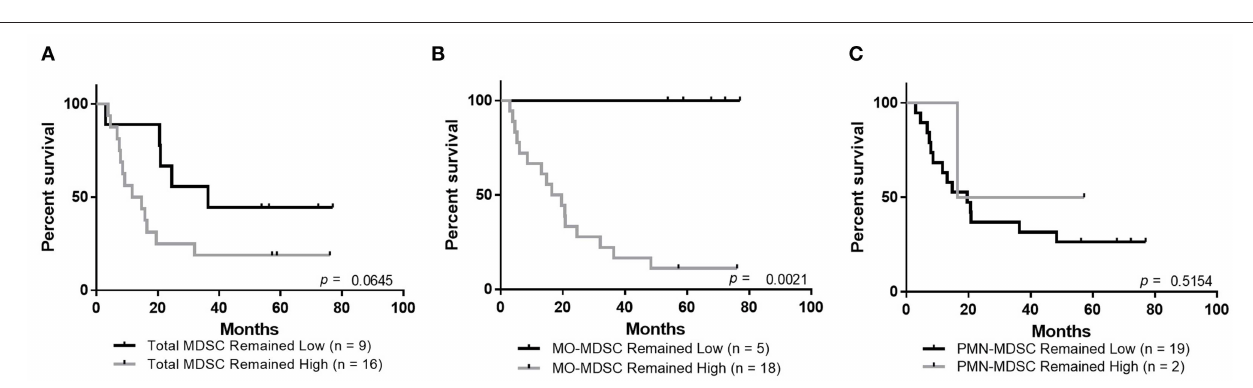
FIGURE 4 | Maintaining low levels of MO-MDSCs is associated with improved overall survival. Overall survival analysis of patients whose levels of circulating (A) total MDSCs, (B) MO-MDSCs, or (C) PMN-MDSCs remained low or remained high during the follow-up